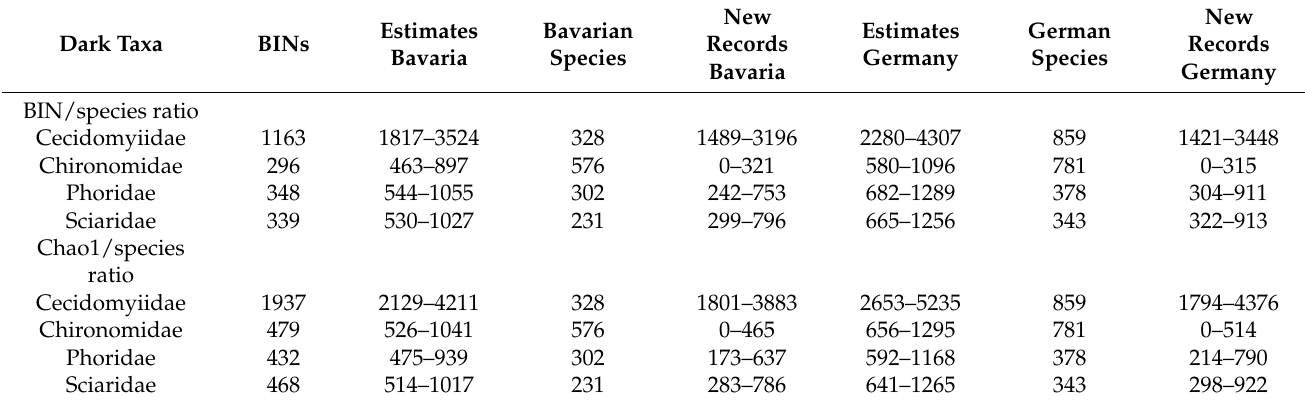
Table 6. BINs and calculated estimates. Total number of BINs recovered for each family from all traps, our calculated estimates, number of recorded species, and potential amplitude of new records for Bavaria and